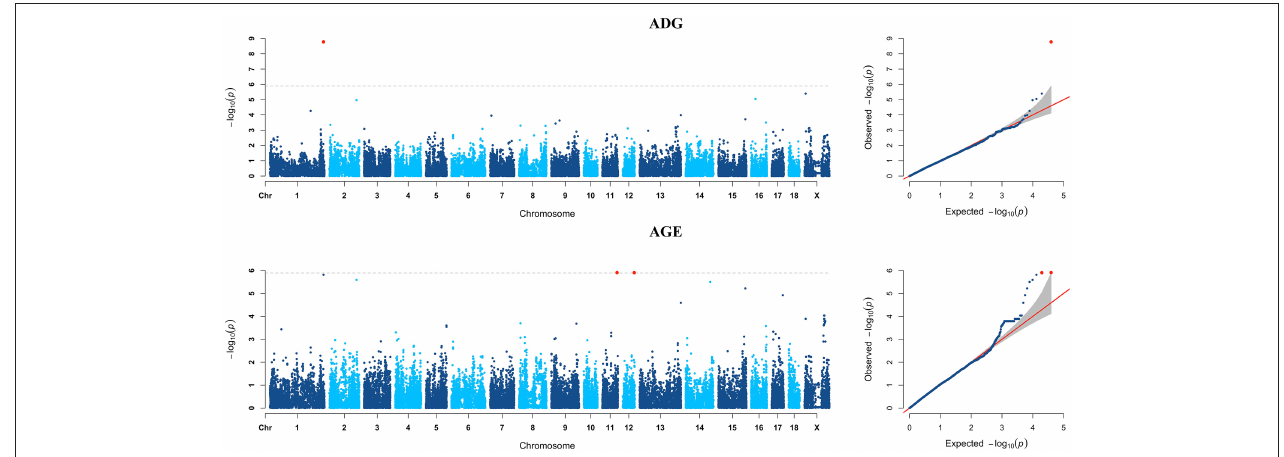
FIGURE 5 | Manhattan plots and Quantile-Quantile (QQ) plots for both ADG and AGE traits of Pietrain breed. The signals of genome-wide significant SNPs are colored in